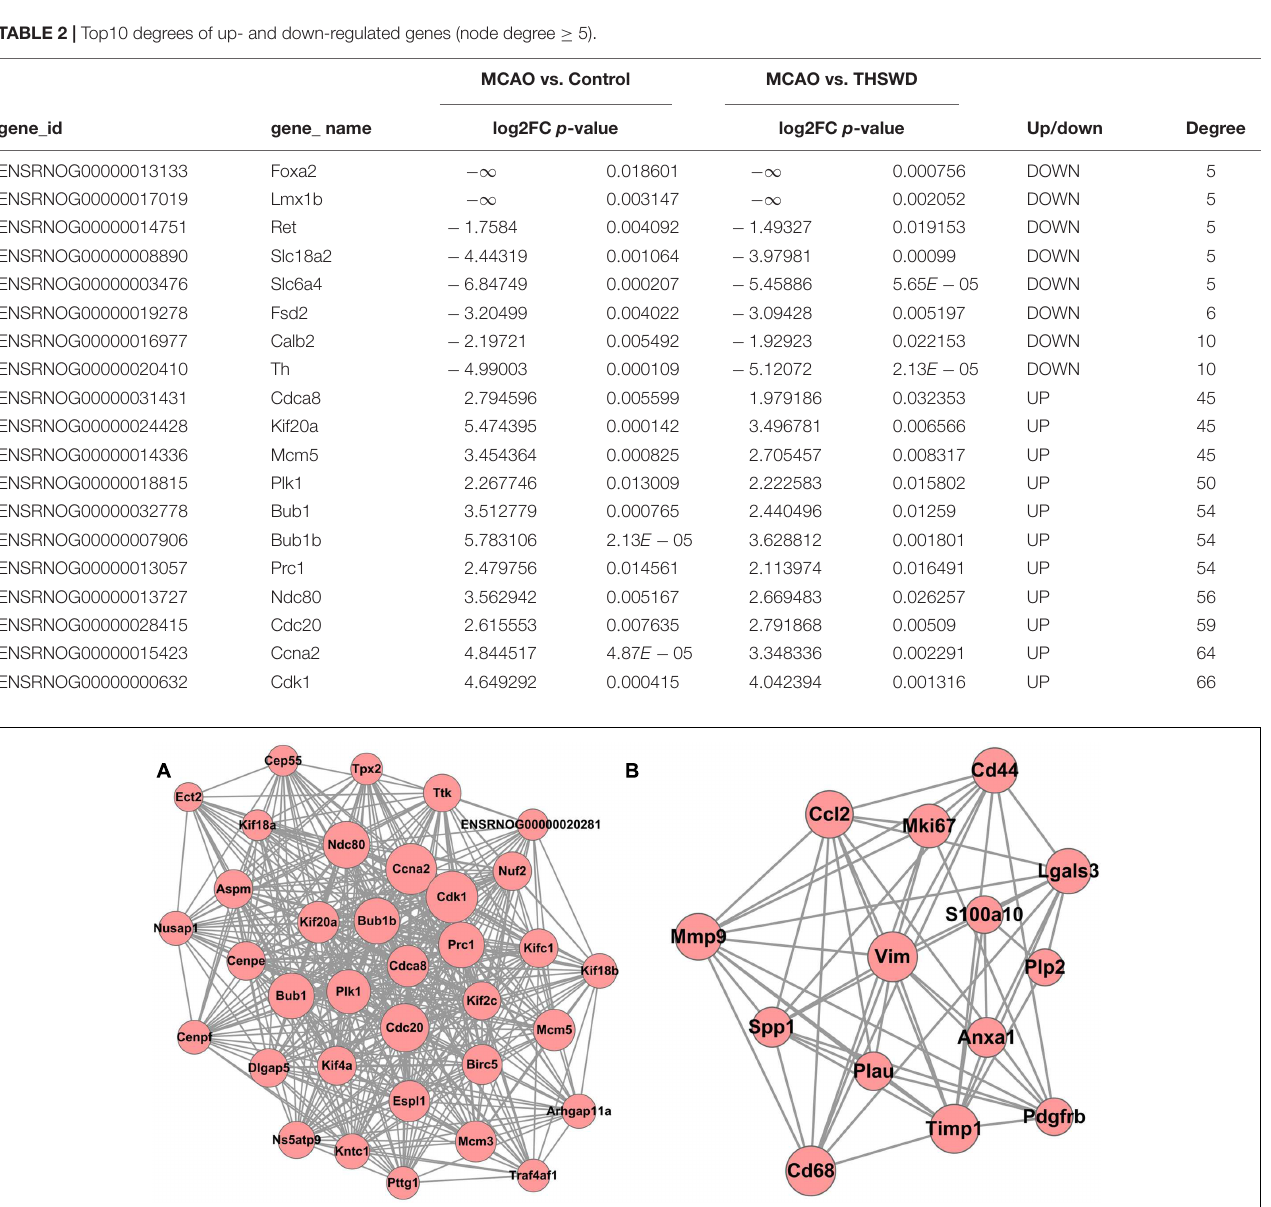
FIGURE 6 | PPI Network of DEGs reversed by THSWD involved in Modules 1 (A) and 2 (B) . Pink nodes denote up-regulated genes; PPI, protein–protein interaction; DEGs, differentially expressed genes.